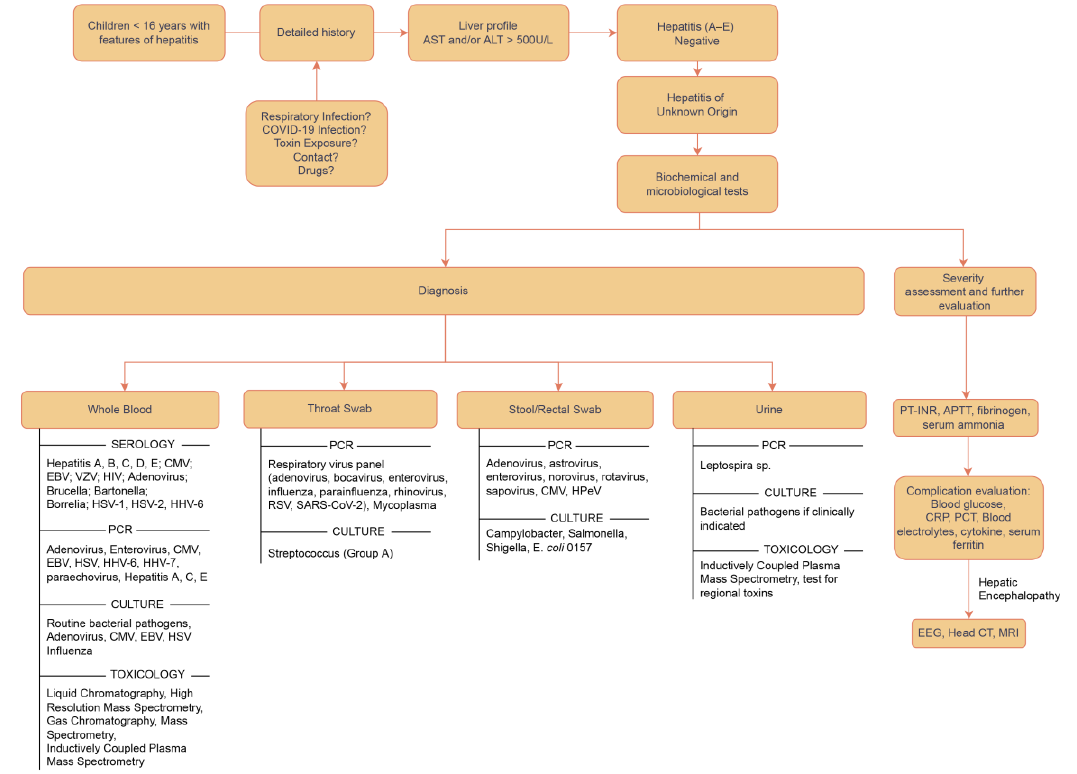
Figure 4. Flowchart depicting the approach to diagnosis for acute hepatitis of unknown origin